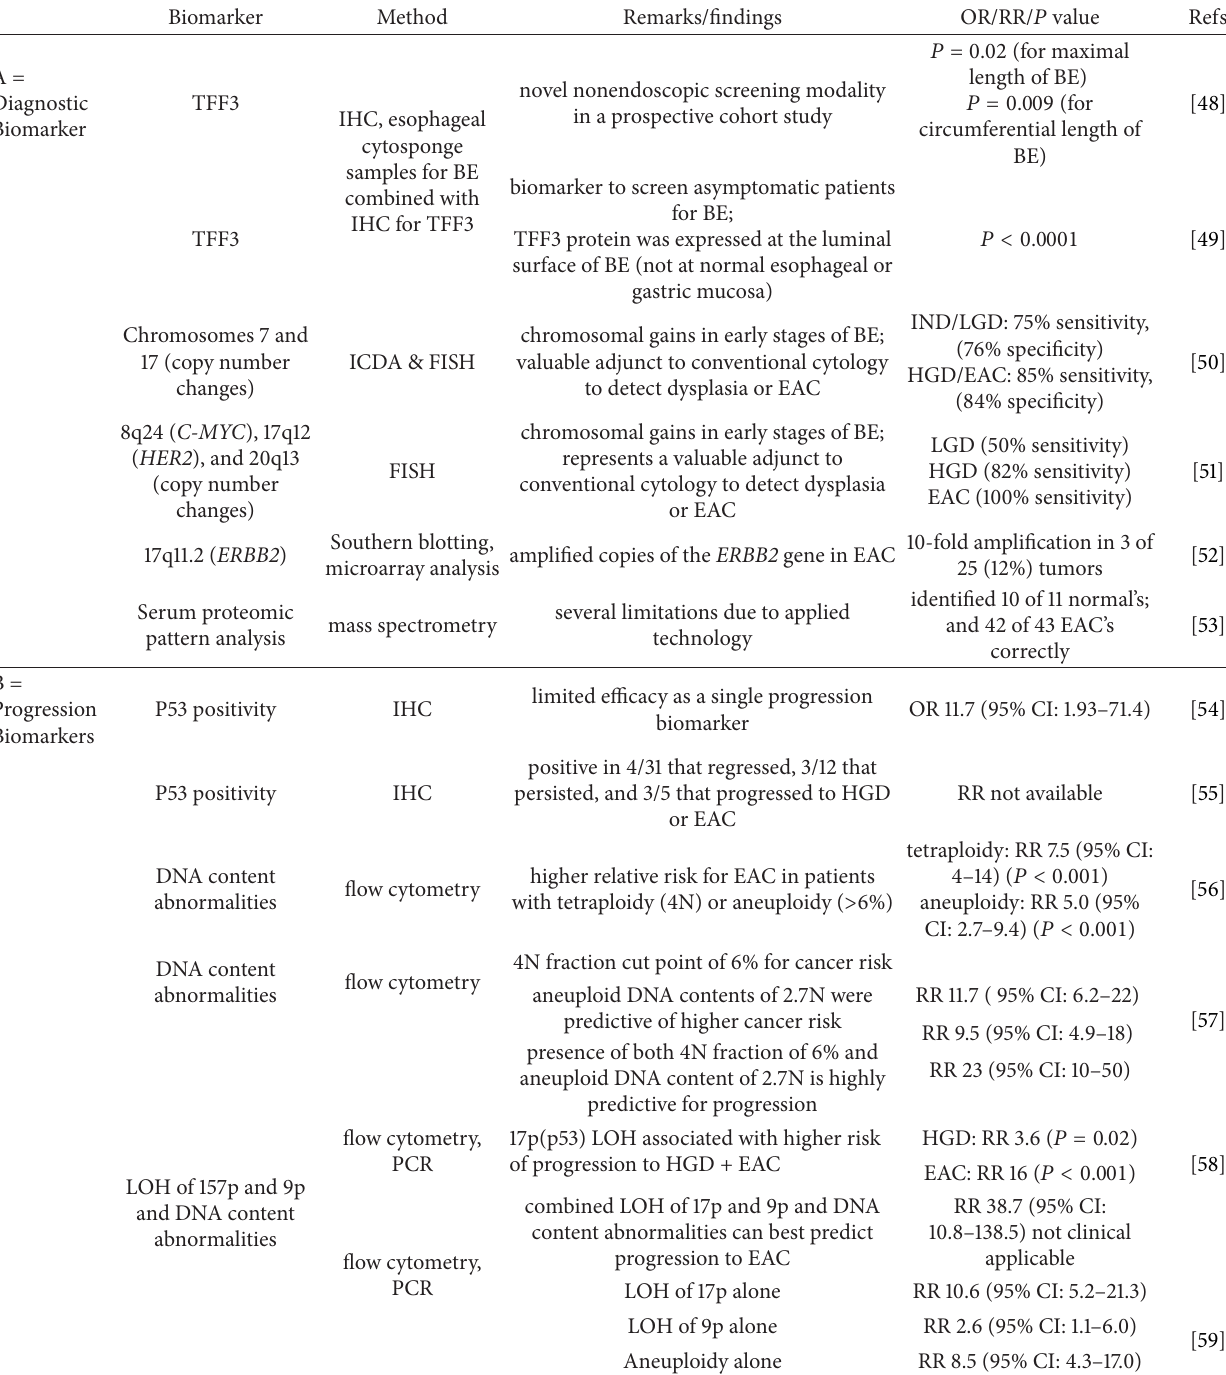
Table 1: Summary of investigated and published biomarkers in the GERD-BE-EAC axis. The categorization is based on four groups according to their potential usage as A = Diagnostic Biomarker indicates the presence of disease, B = Progression Biomarker indicates the risk of developing cancer—progression in BE to EAC, C = Predictive Biomarker predicts response to therapy (CTX, RTX, photodynamic therapy), or D = Prognostic Biomarker indicates overall survival—prognostic in EAC (survival,